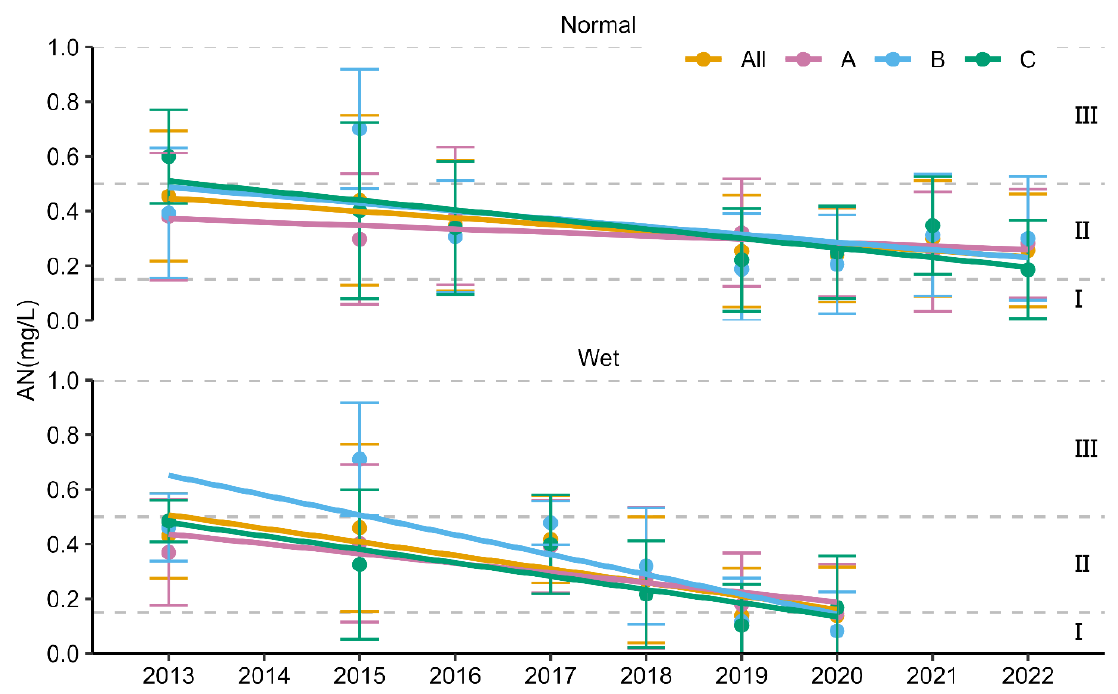
Figure 5. Time series of mean Landsat 8-monitored AN of the NRD for the whole region (All) and three subregions (A, B, and C) in dry, normal, and wet seasons from 2013 to 2022. Ⅰ , Ⅱ , and Ⅲ are the quality standards for surface water from low to high.